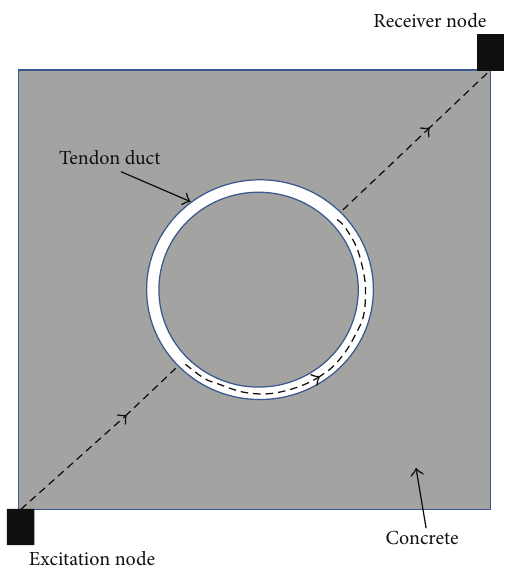
Figure 17: Transmission of elastic wave from source to receiver through tendon